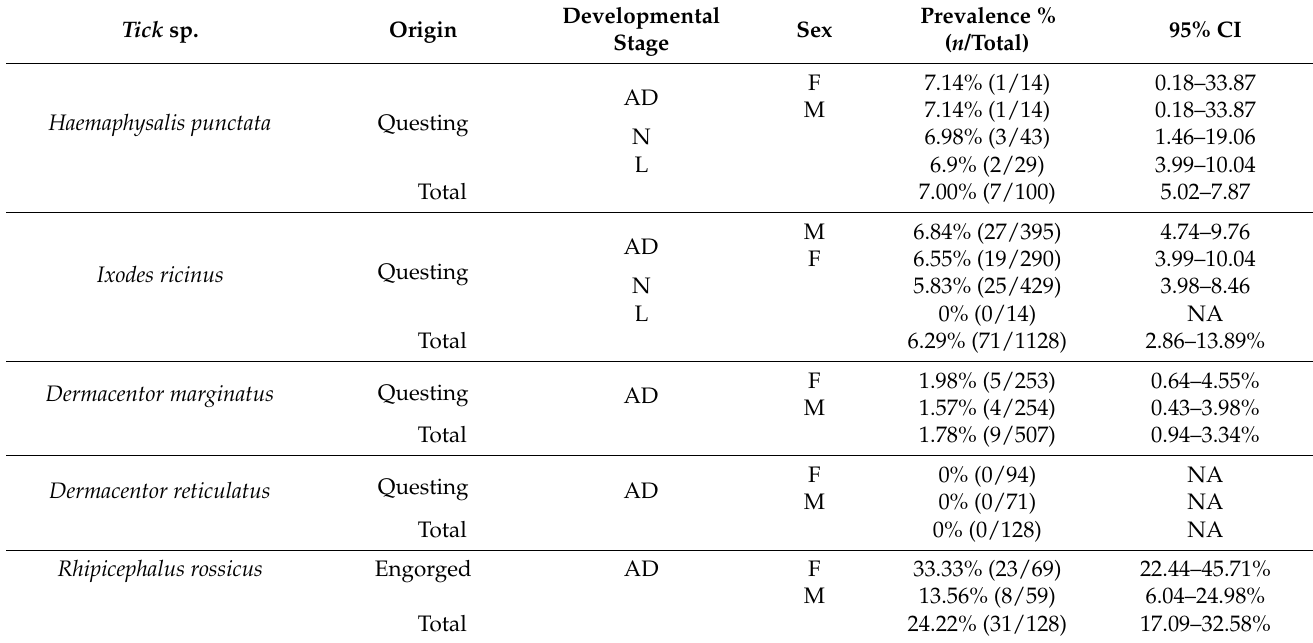
Table 3. Rickettsia spp. prevalence and its distribution according to tick species, developmental stage, and